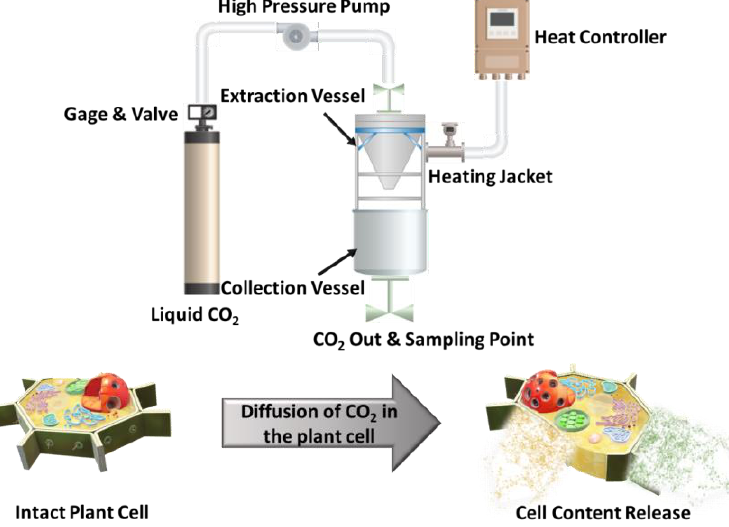
Figure 7. Schematic representation of a supercritical carbon dioxide extraction system.